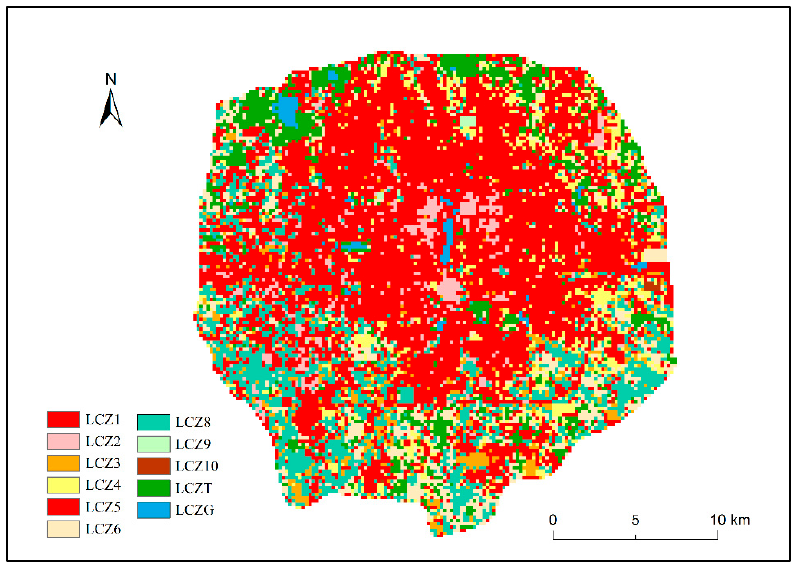
Figure 6. Spatial distribution of the LCZ in the study area (within the fifth ring of Beijing). Table 4. Confusion matrix of LCZ classification